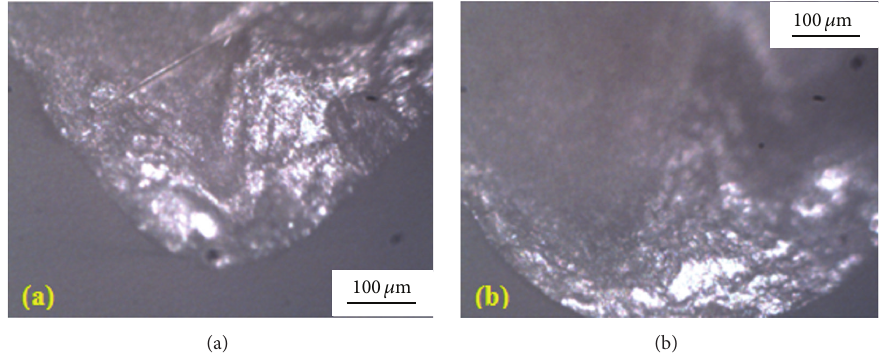
Figure 15: Microtexture of insert after turning: (a) 0.4 mm nose radius and (b) 0.8 mm nose